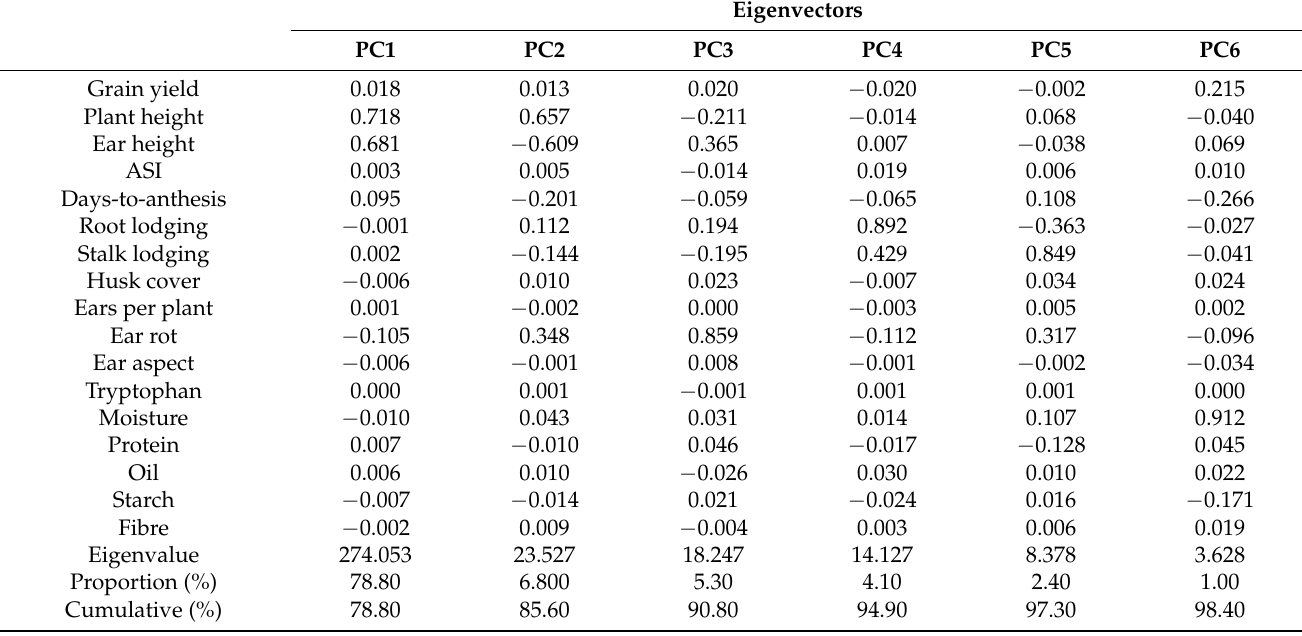
Table 4. Principal component analysis of maize hybrids for grain yield, agronomic and quality traits.